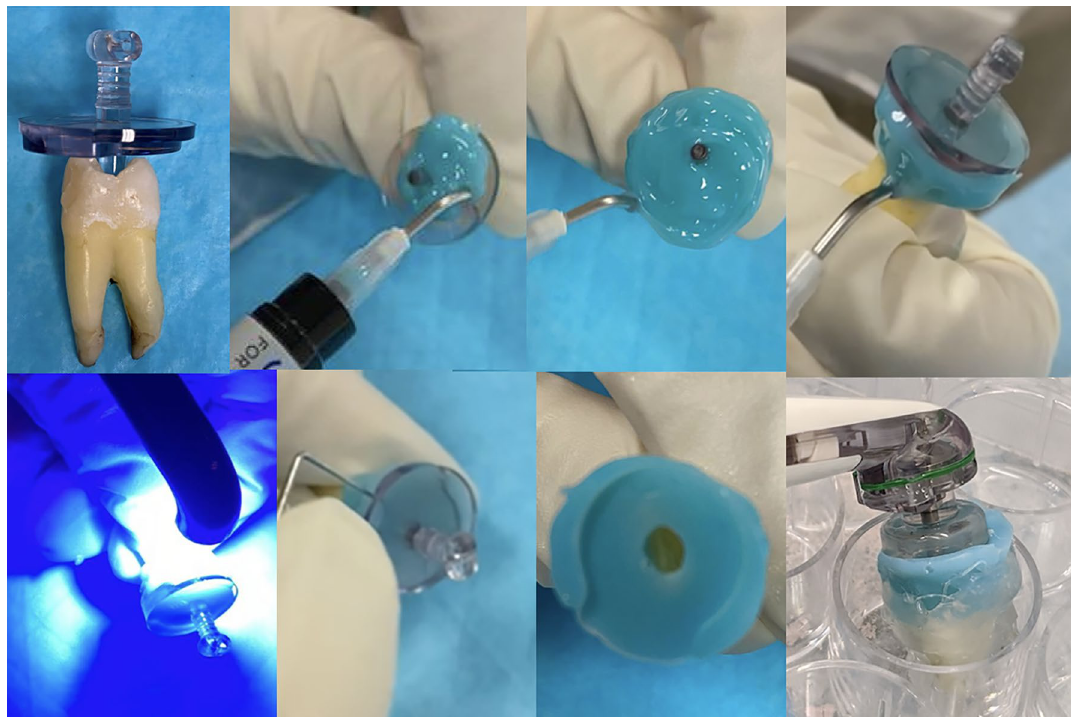
Figure 1. Occlusal platform building for the GentleWave System